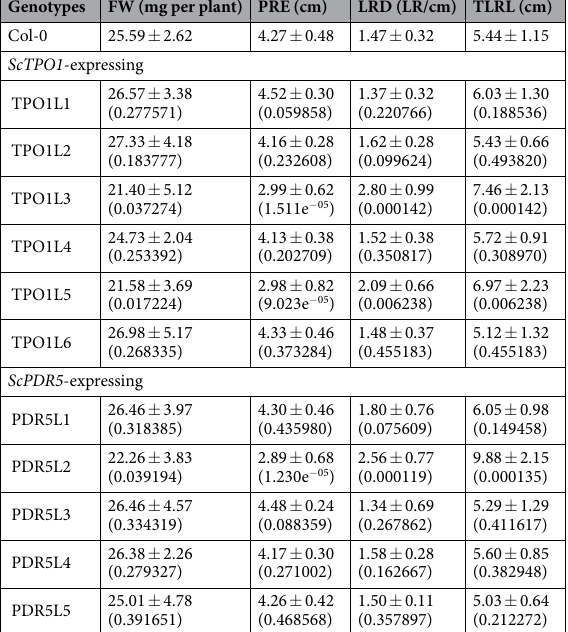
Table 1. Growth parameters under control conditions of transgenic Arabidopsis lines expressing the yeast Tpo1p or Pdr5p transporters. Shoot biomass (fresh weight, FW), primary root elongation (PRE), lateral root density (LRD) and total lateral root length (TLRL) of 7-d (PRE) or 14-d (FW, LRD, TLRL) old seedlings from the wild type (Col-0) or ScTPO1 - and ScPDR5 -expressing lines grown in control medium. Values represent means ± SD ( n = 8), with similar results being obtained in three independent experiments performed with different seed batches. Numbers in parentheses indicate the P value (comparison with the wild type) obtained by Student’s t